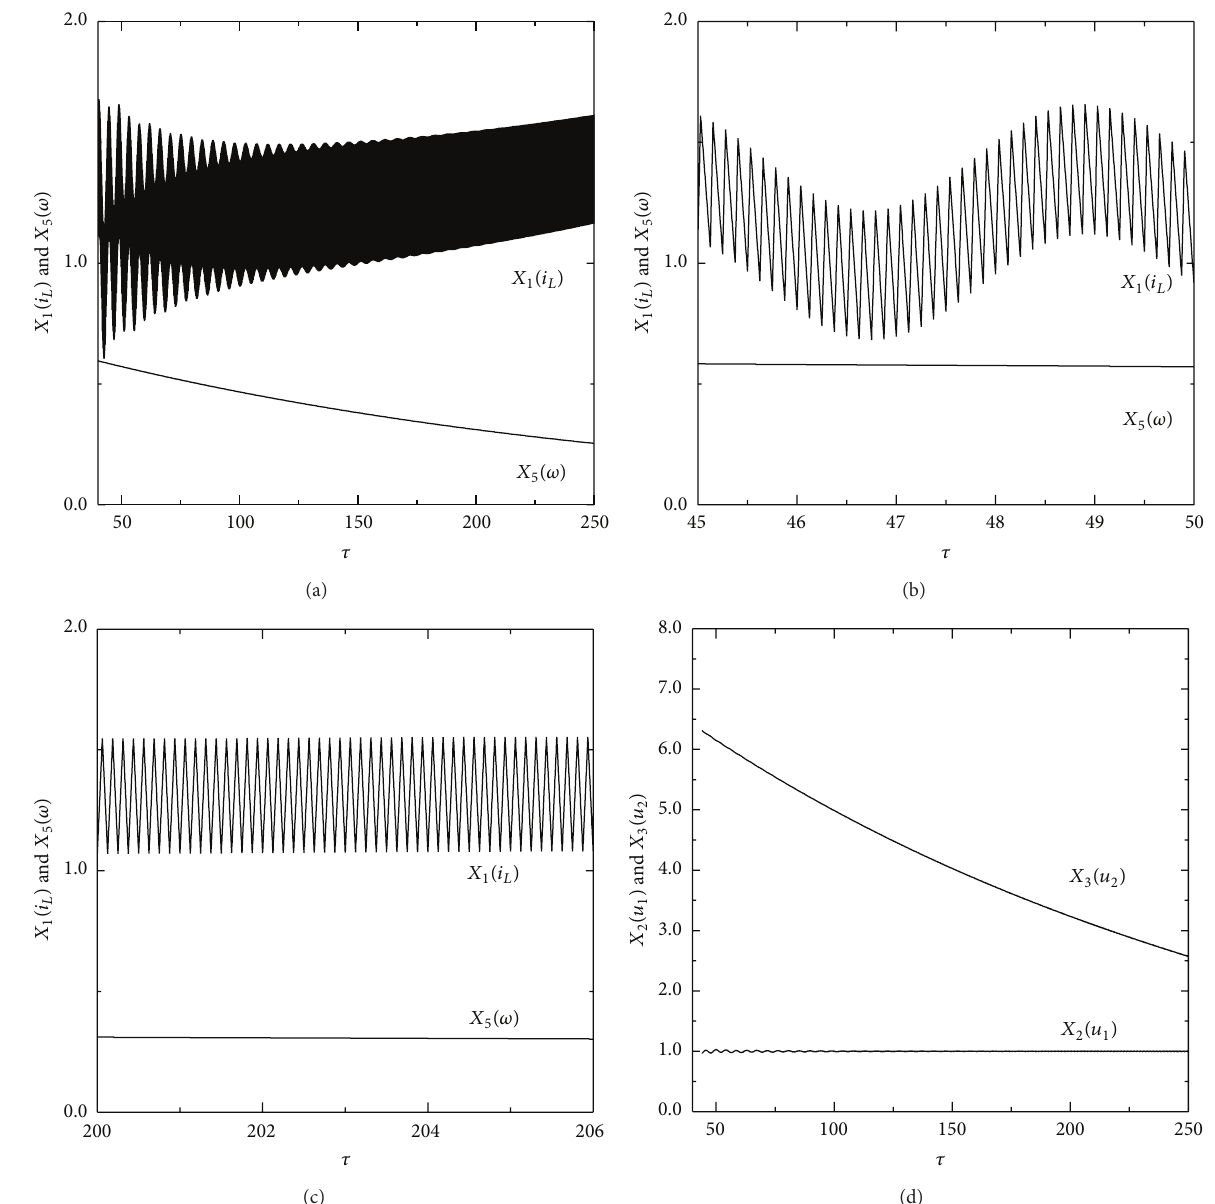
= 5 V, for (a) 𝑋 ref